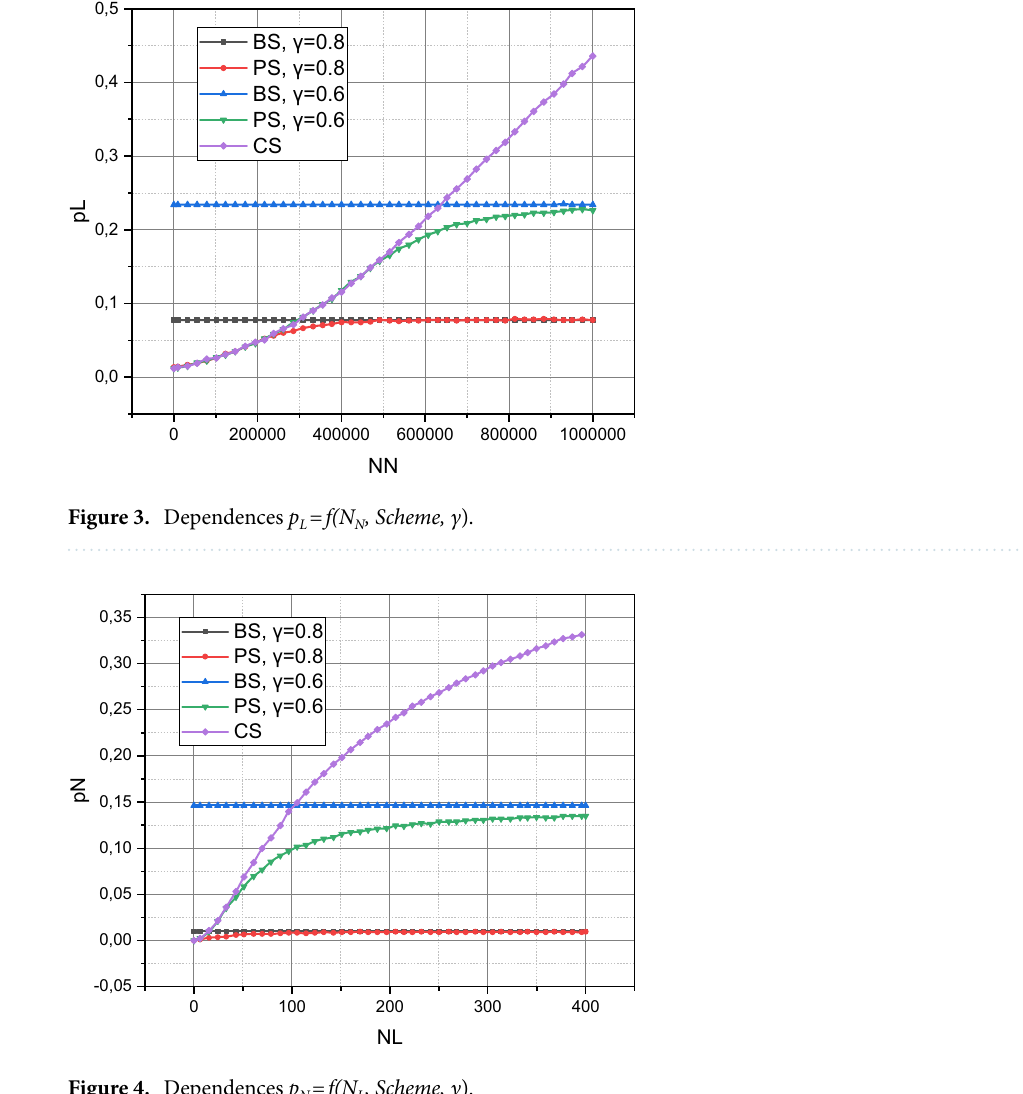
Figure 4. Dependences p N = f(N L , Scheme, γ